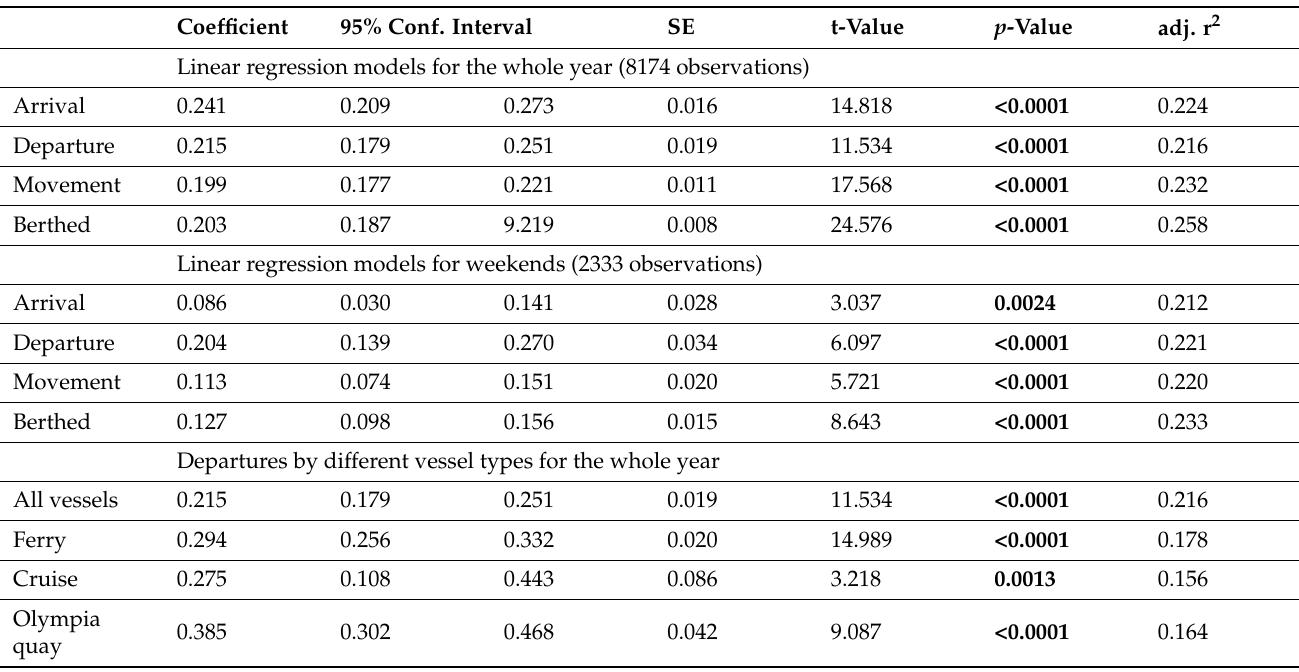
Table 6. Multivariable linear regression analysis results for vessel arrivals, departures, movement and laying alongside to the logarithm of NO 2 hourly mean concentrations controlled for wind direction, wind speed, air temperature (not in the weekend models) and time of day at the South Harbour 2018. p -values less than 0.05 in